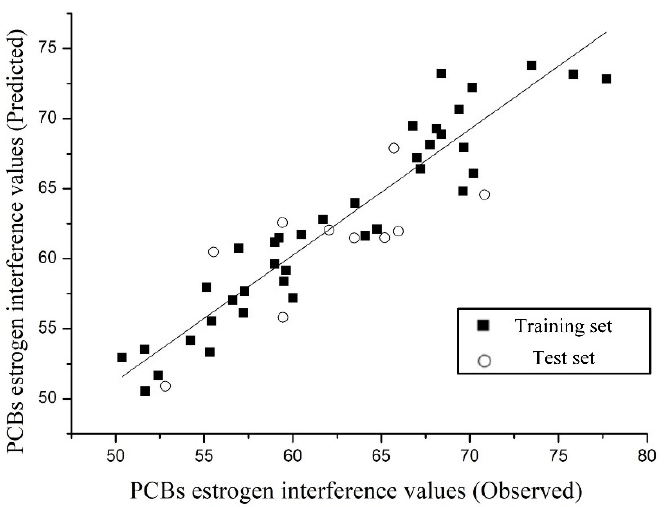
Figure 3. The plot of the observed vs. estimated estrogen interference values by the 3D-QSAR mod- els.